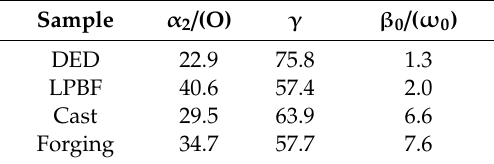
Table 4. The phase composition of heat-treated TNM-B1 samples; values in